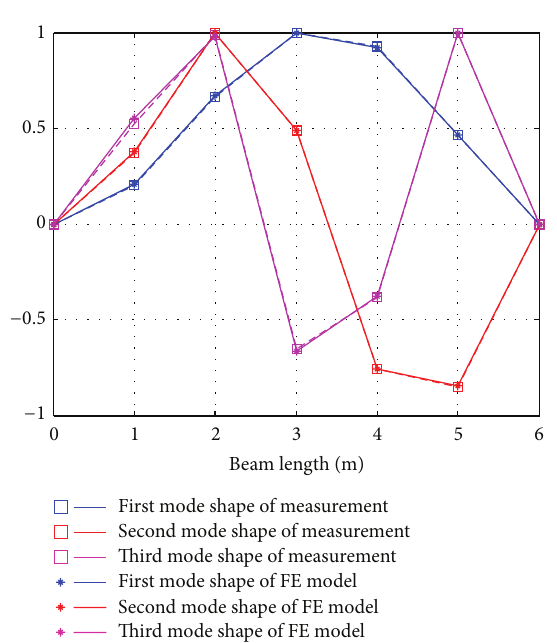
Figure 4: Comparison of mode shapes from measurements and updated model for single damage case.